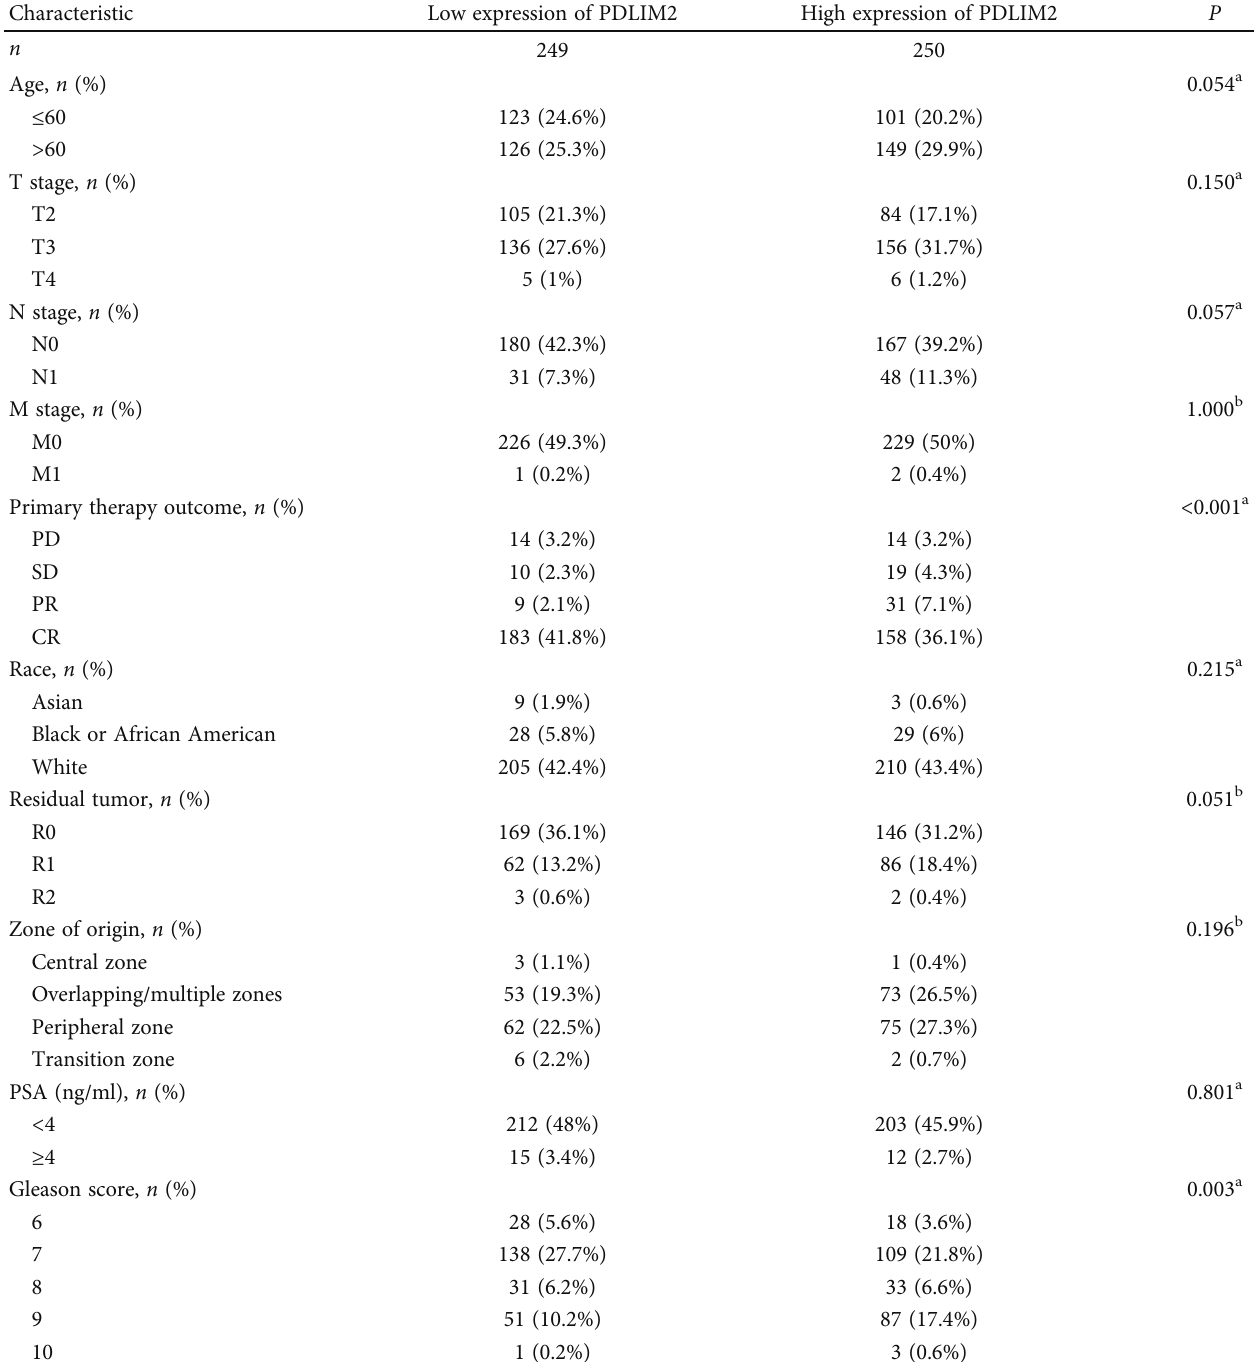
Table 1: Association between low- or high-PDLIM2 mRNA expression and clinicopathological features in TCGA-PRAD cohort. Characteristic Low expression of